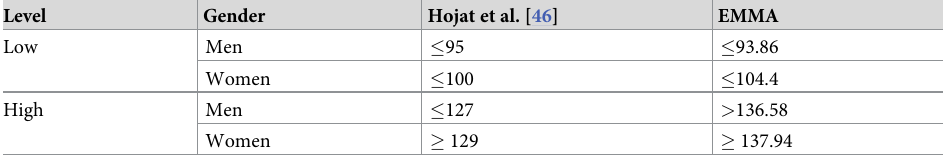
Note: Comparison with cut-off points presented by Hojat et al. [39] in 2,637 students at Sidney Kimmel